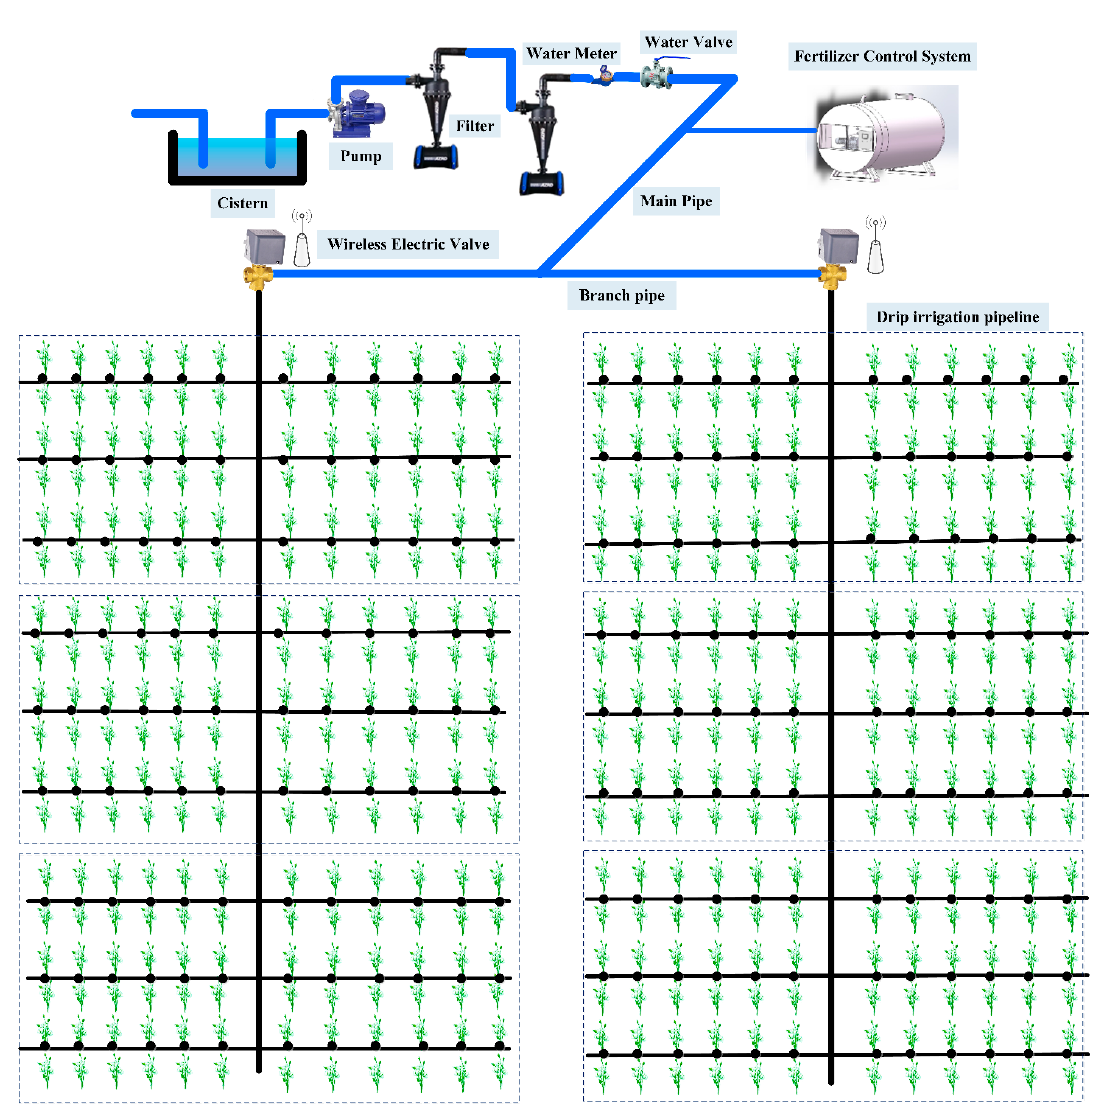
Figure 5. Framework of water and fertilizer integration system in an experimental cotton field.